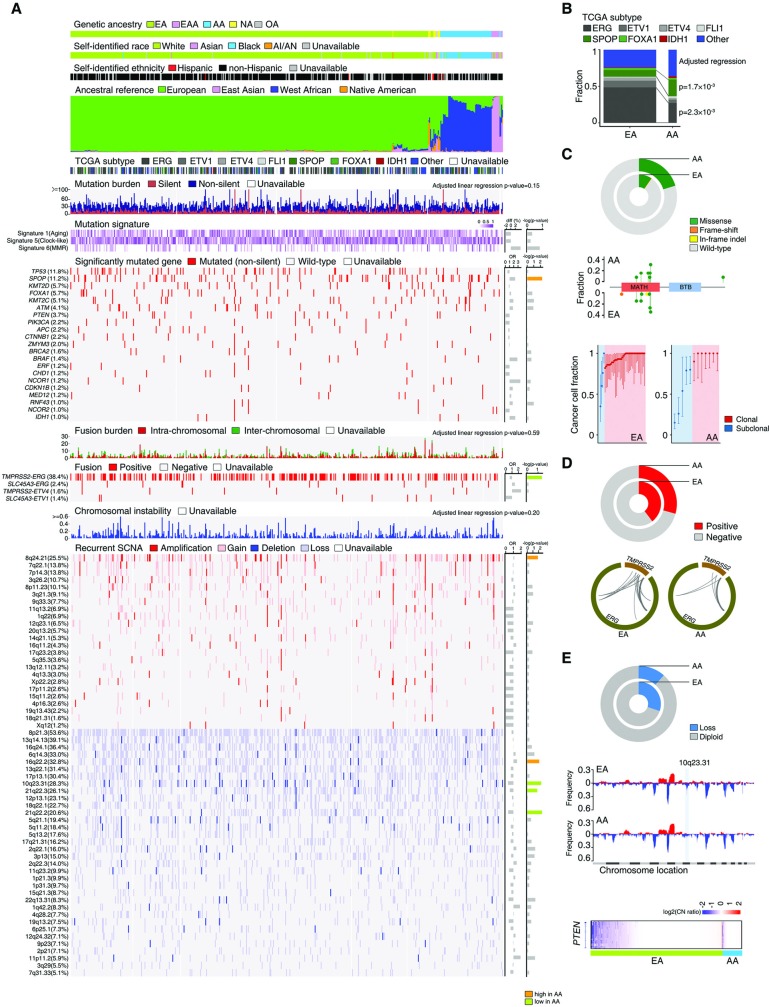
Comparison of genomic alterations by genetic ancestry.(A) Overview of genomic alterations by genetic ancestry in the TCGA CaP cohort. The upper panels show patient genetic ancestry estimated by EIGENSTRAT, SIRE, and ancestral composition estimated by STRUCTURE. Middle panels show participant tumor molecular subtype, mutation burden, presence of mutation signatures 1, 5, and 6, and a heatmap of the mutation frequency at 21 specific genes with ≥1% mutation frequency in the sample. Lower panels show total fusion burden, a heatmap of the frequency of four gene fusions with ≥1% frequency in the sample, total chromosomal instability, and a heatmap of the frequency of 58 recurrent focal somatic copy number alterations (red: amplification/gain; blue: deletion/loss) in the sample. Odds ratios (OR) and differences (diff) compare genomic alteration frequency among men with AA ancestry relative to men with EA ancestry.–log(p-values) are color-coded as significantly more frequent in AA men (orange), significantly less frequent in AA men (green), or no significant difference between AA and EA men (gray). (B) Distributions of seven TCGA CaP molecular subtypes among men with AA and EA ancestry. Men with AA were more likely to have SPOP subtype tumors and less likely to have ERG subtype tumors. (C) Frequency (upper), location (middle), and clonality (lower) of SPOP mutations among men with AA and EA ancestry. SPOP mutations more frequently occurred in men with AA ancestry (upper). Mutations were preferentially located in the MATH domain for men with AA and EA ancestry. Mutations are color-coded by type: missense (green), frame-shift (red), in-frame insertion/deletion (yellow). Men with AA ancestry had a greater frequency of subclonal SPOP mutations than men with EA ancestry (lower). Red represents clonal mutations and blue represents subclonal mutations. (D) Frequency of the TMPRSS2-ERG fusion (upper) and distribution of gene breakpoint sites (lower) by genetic ancestry. The TMPRSS2-ERG fusion was more prevalent among men with EA ancestry, although breakpoint site patterns were similar among men with EA and AA ancestry. (E) Copy number deletions and losses at 10q23.31 were more common among men with EA ancestry than with AA ancestry (upper). The lower prevalence of 10q23.31 loss for AA men is evident when viewing copy number alterations across the genome (middle). Greater focus on the PTEN locus indicates that PTEN loss is less common among men with AA ancestry (lower).